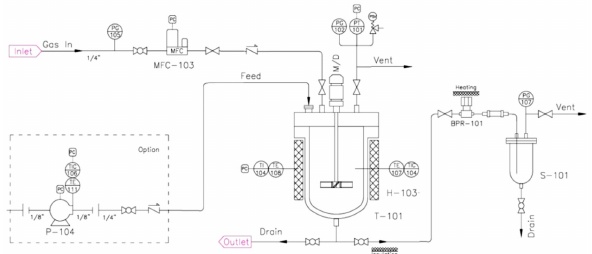
Figure 1. The laboratory-scale plant.